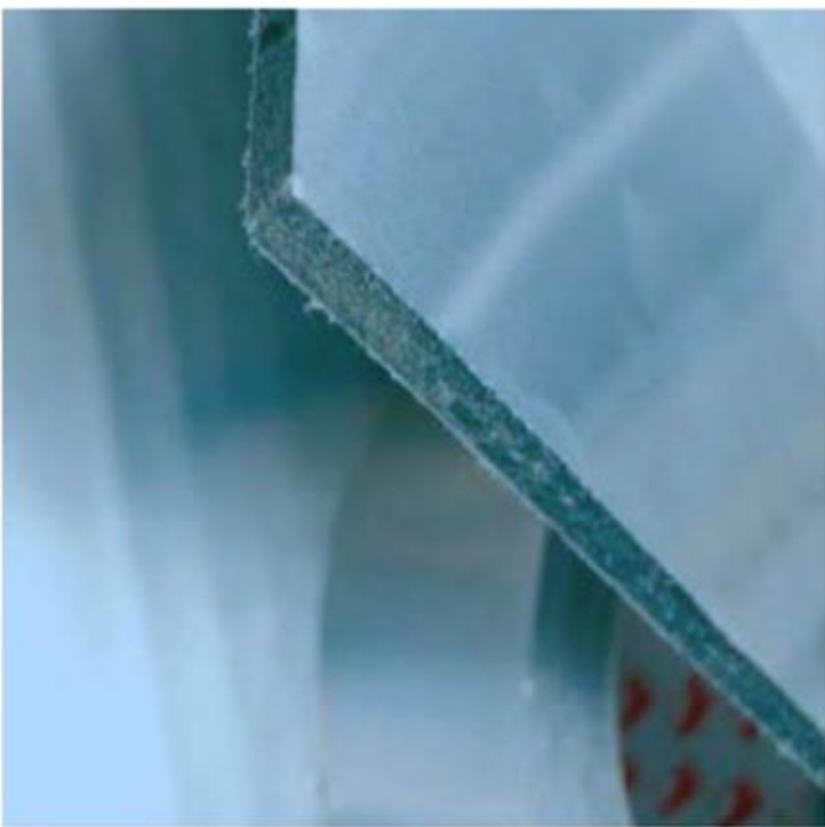
Figure 15. Energain ® PCM panel wrapped and sealed in foil tape [141]. Microencapsulated PCMs (e.g., paraffin) can be mixed directly with gypsum and used in the form of a panel, as shown in Figure 16 from Micronal ® produced by the BASF (Ludwigshafen, Germany). In this way, the wallboard can be used as a normal wallboard, which is much more energy-efficient than one without PCMs in it